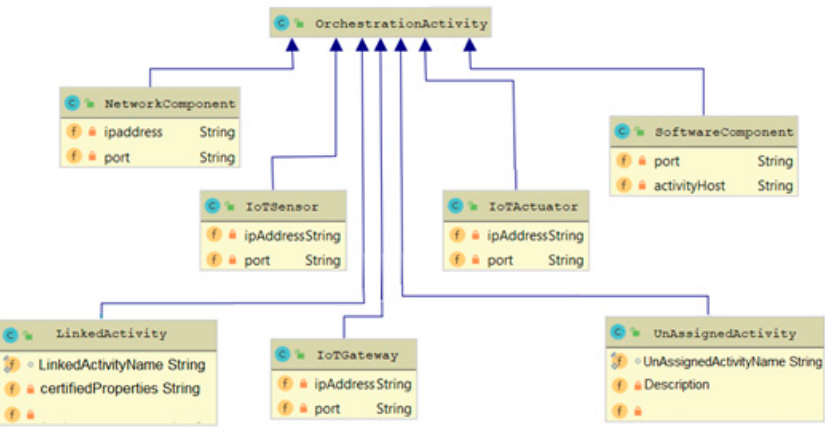
Figure 29. Descriptive overview of OrchestrationActivity class and its subclasses.